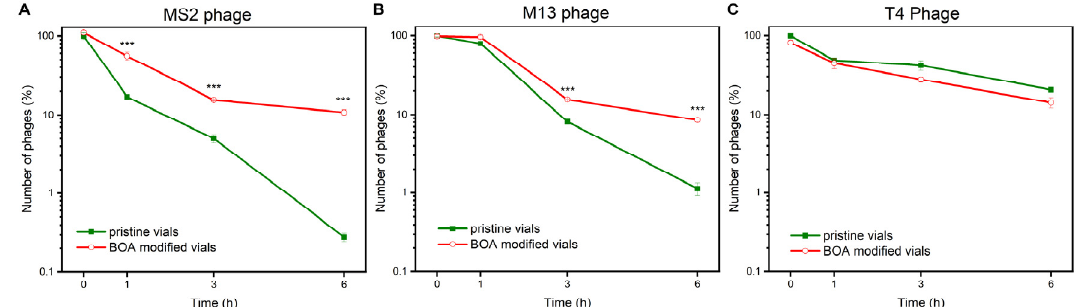
Figure 2. Comparison of the number of bacteriophages presented as a percent of concentration at 0 h. The initial concentrations were ( A ) 3.75 × 10 3 ± 3.74 × 10 2 PFU/mL for MS2, ( B ) 5.08 × 10 3 ± 1.60 × 10 2 PFU/mL for M13, and ( C ) 6.60 × 10 5 ± 5.01 × 10 4 PFU/mL for T4. The visible decrease was visible in pristine vials in M13 and MS2 but not in T4. BOA showed the statistically significant protection against the phage titer decrease in the case of M13 and MS2 and did not show any adverse effect on T4 suspensions (*** p < 0.001).